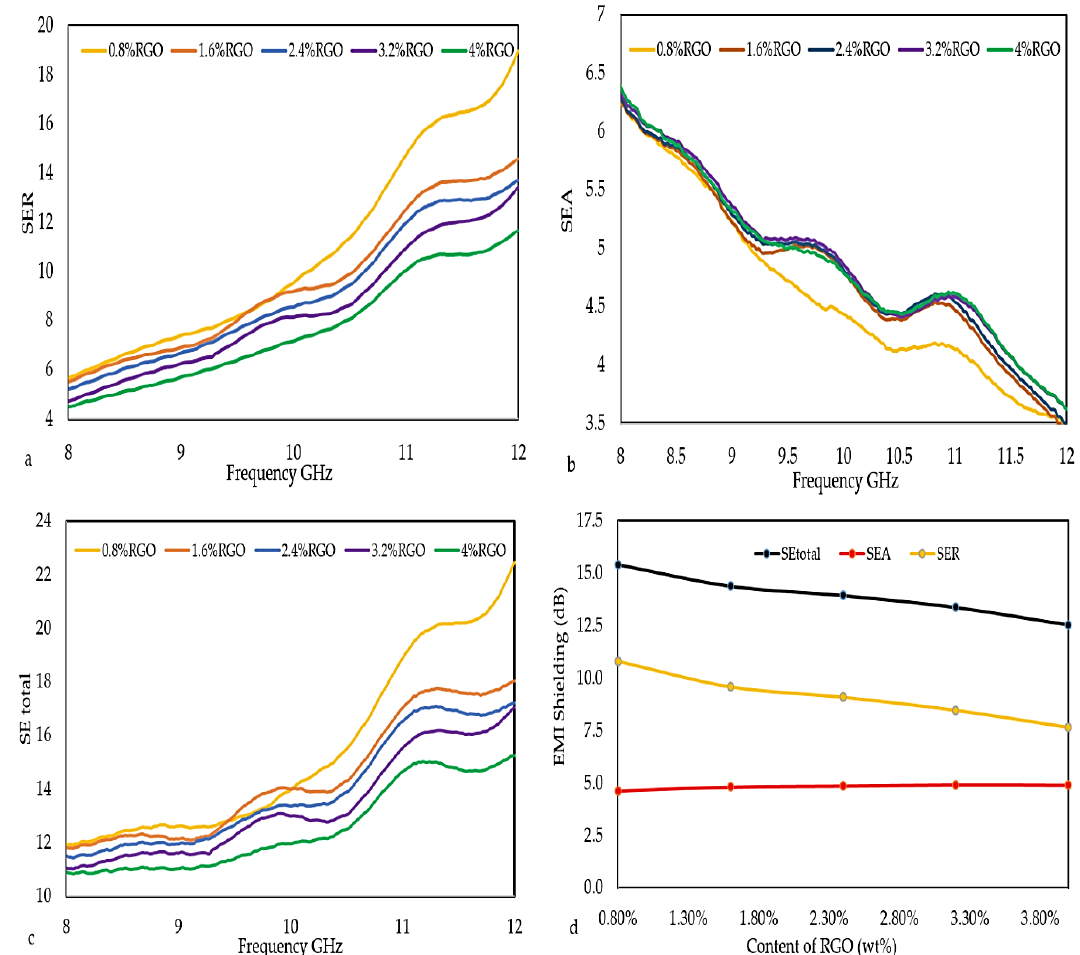
Figure 12. Variation of EMI Shielding Efficiency (EMI SE) against frequency (Hz) for ( a ) SE R , ( b ) SE A , ( c ), SE total , and ( d ) The Shielding Effectiveness (SE) at versus RGO loadings.